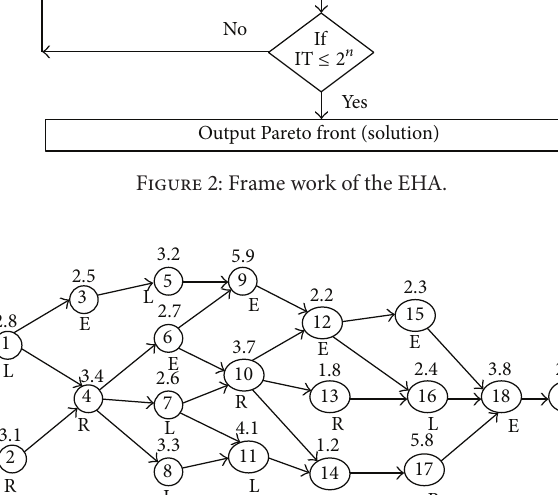
Figure 3: Precedence diagram along with task time and operation directions of P19 -